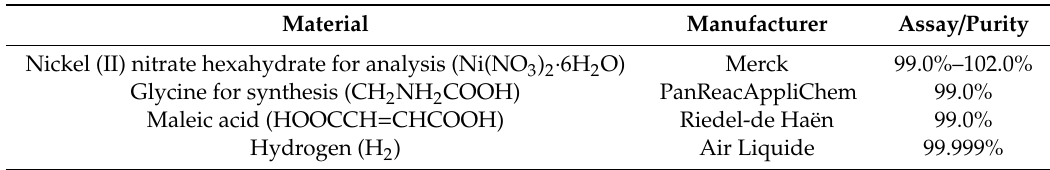
Table 1. Materials used for solution combustion synthesis (SCS) catalyst production and the hydrogenation reaction.